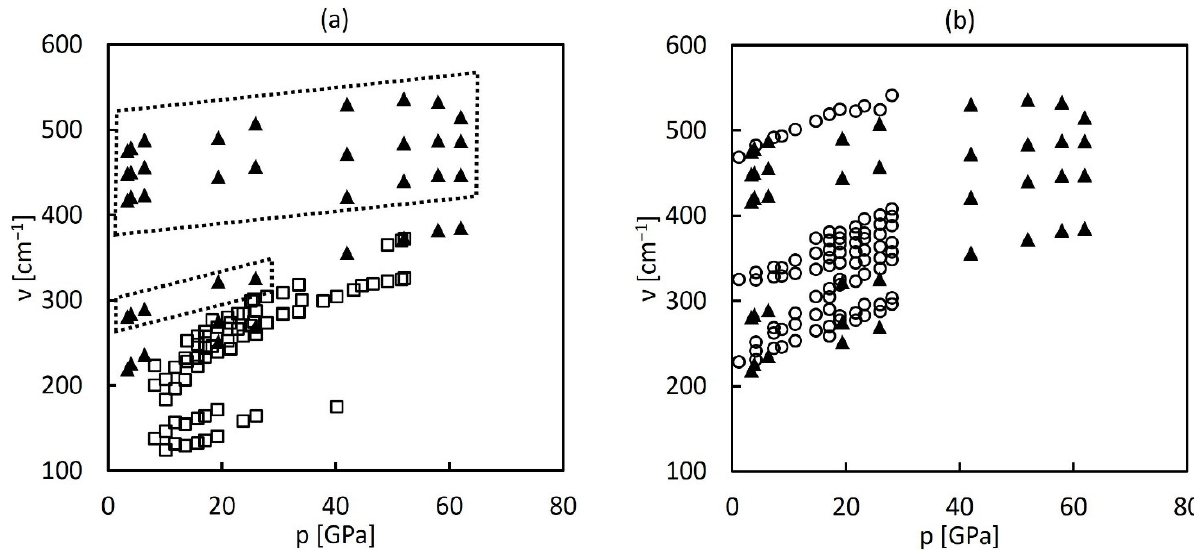
Figure 4. Comparison of new bands appearing in spectra from experiments A and B (solid triangles) with: ( a ) known bands from solid chlorine (this work, hollow squares), ( b ) known bands from solid CCl 4 (ref. [41], hollow circles). Cl-Cl intramolecular vibron band appearing at 550–600 cm –1 is omitted for clarity. Dashed parallelograms indicate bands unaccounted for by Cl 2 or CCl 4 . Reproduced with permission from ref. [41]. Copyright 2014 AIP Publishing.